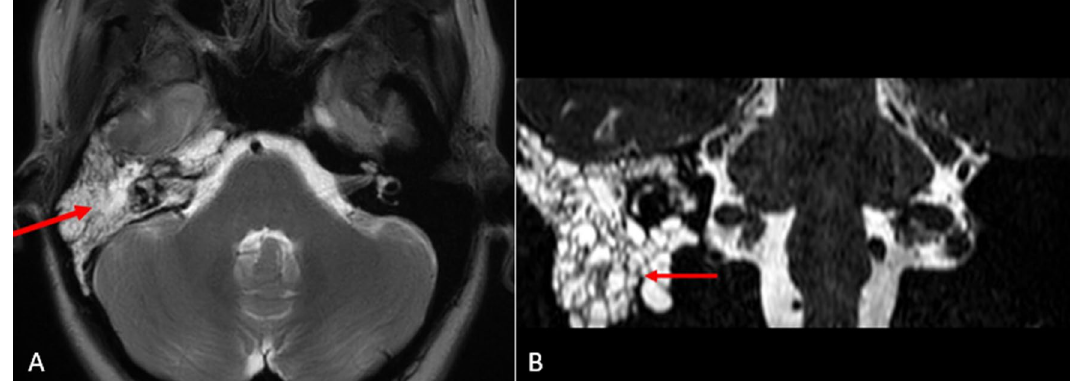
Fig. 3 A T2W axial section showing T2 hyperintensity within the right mastoid air cells (red arrow) and middle ear cavity. It is further seen extending to involve the hyper-pneumatized right petrous body. B MRI CISS coronal section showing the T2 hyperintensity within the right mastoid air cells (red arrow)